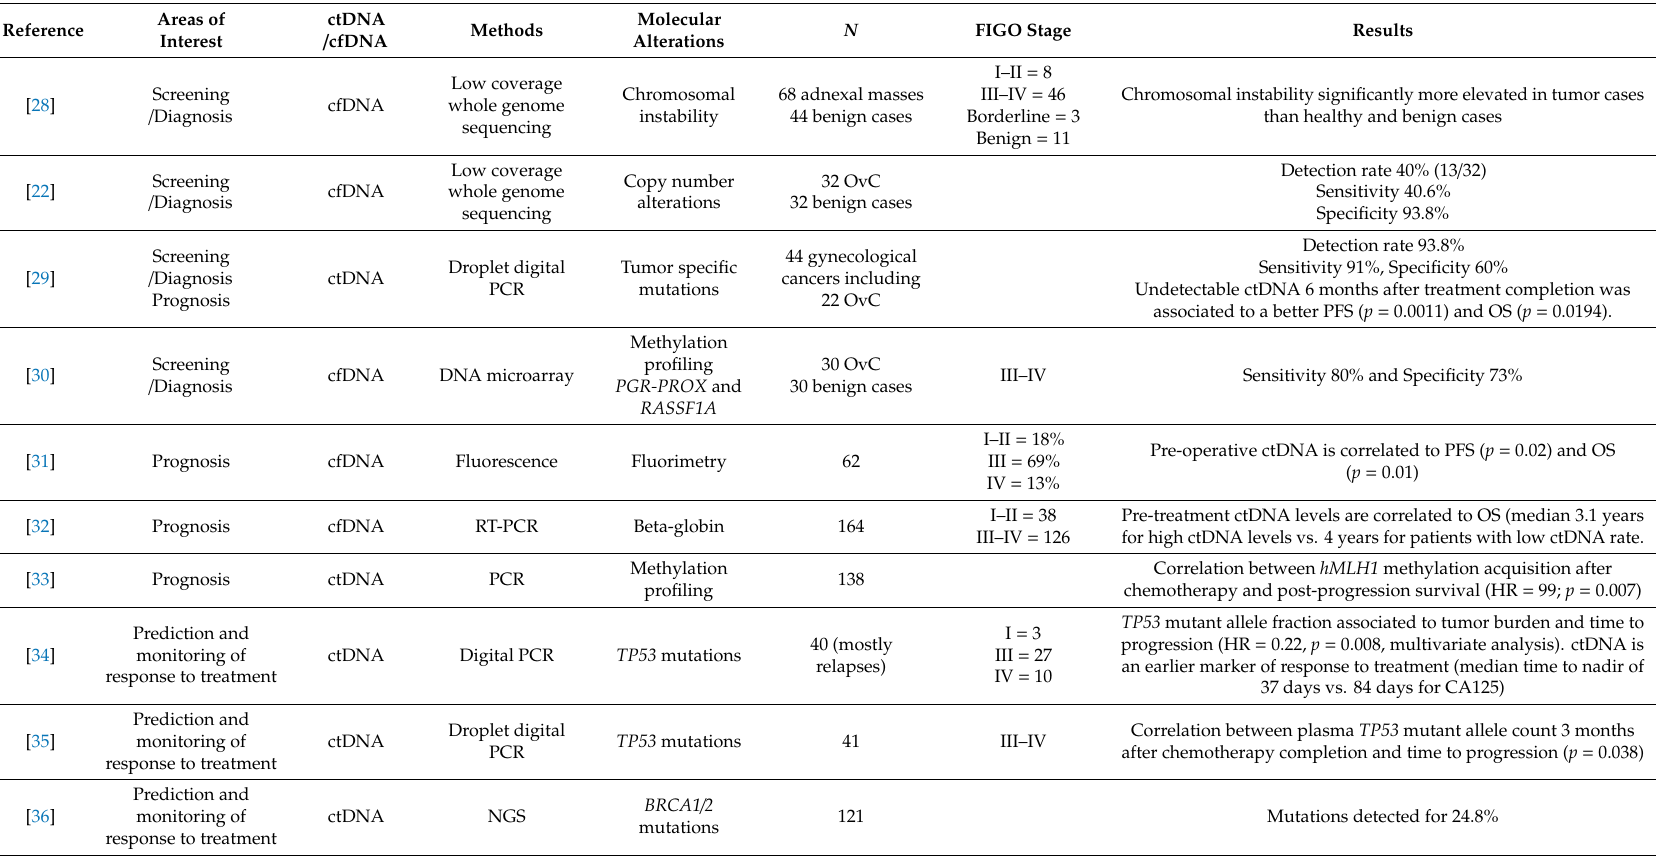
Table 1. Published works concerning circulating tumor DNA and cell-free DNA analyses for patients with ovarian epithelial cancer. OvC, ovarian cancer; PCR, polymerase chain reaction; RT-PCR, reverse transcription polymerase chain reaction; NGS, next generation sequencing; PFS, progression-free survival; OS, overall